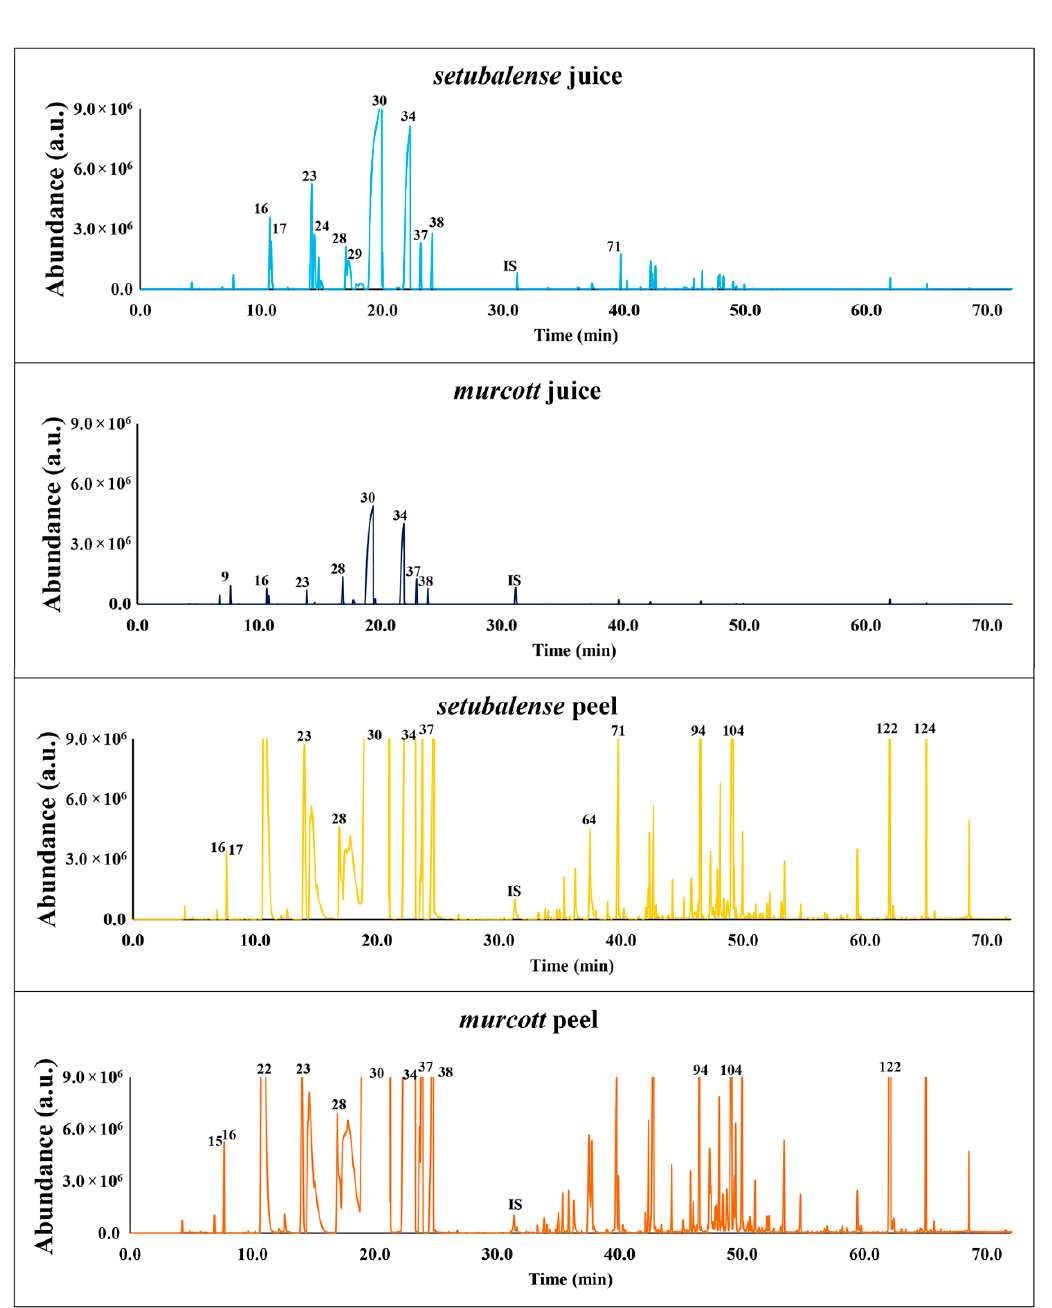
Figure 1. Representative chromatograms of the analyzed samples. Numbers above the peaks refer to the volatile organic metabolites (VOMs) identified in Supplementary Table S1. Peak number